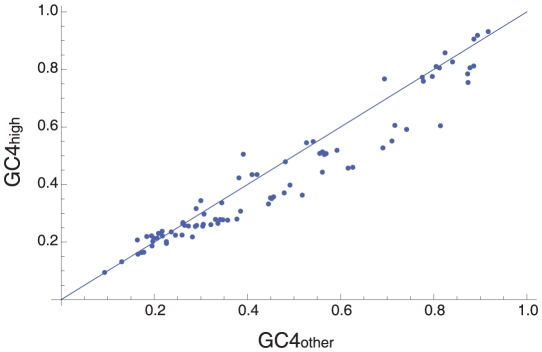
Translational selection.The figure shows the relationship between GC4 for putatively highly expressed genes and GC4 for all other annotated genes. The line is for GC4high = GC4other.